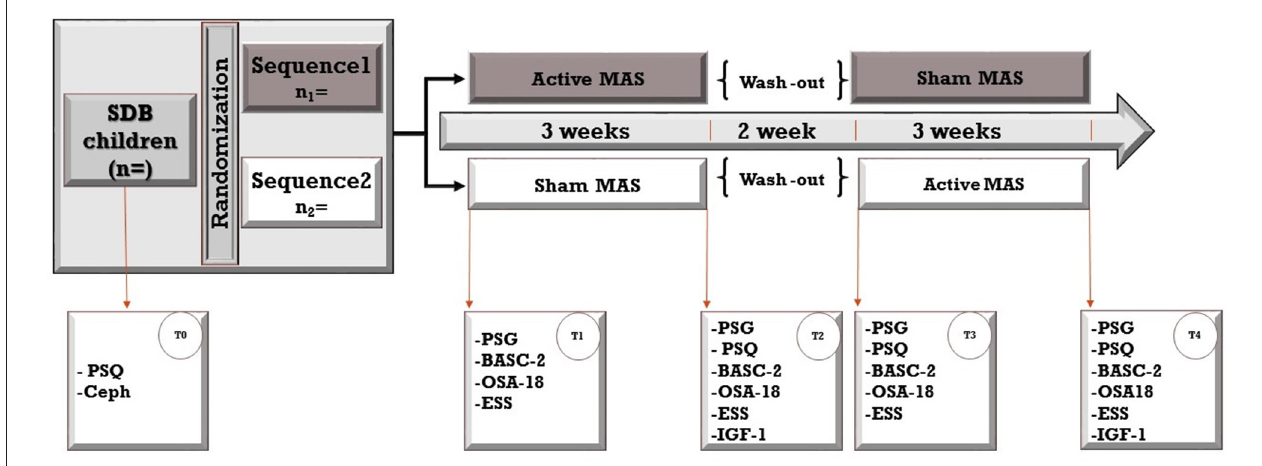
FIGURE 4 | The study design is a crossover randomized controlled trial. Sixteen patients will be randomly assigned to two sequences; both sequences include a 3-week treatment period with active and non-active (sham) mandibular advancement splints but in a different order (Active followed by Non-active and Non-active followed by Active). Treatment periods will be separated by a 2-week washout period. Assessments will be taken at baseline (T0) and four times throughout the study. PSF, polysomnography; Ceph, Cephalograms; PSQ, Pediatric Sleep Questionnaire; BASC-2, Behavior Assessment System for Children, second edition; OSA-18, Quality of Life questionnaire; ESS, Epworth Sleepiness Scale